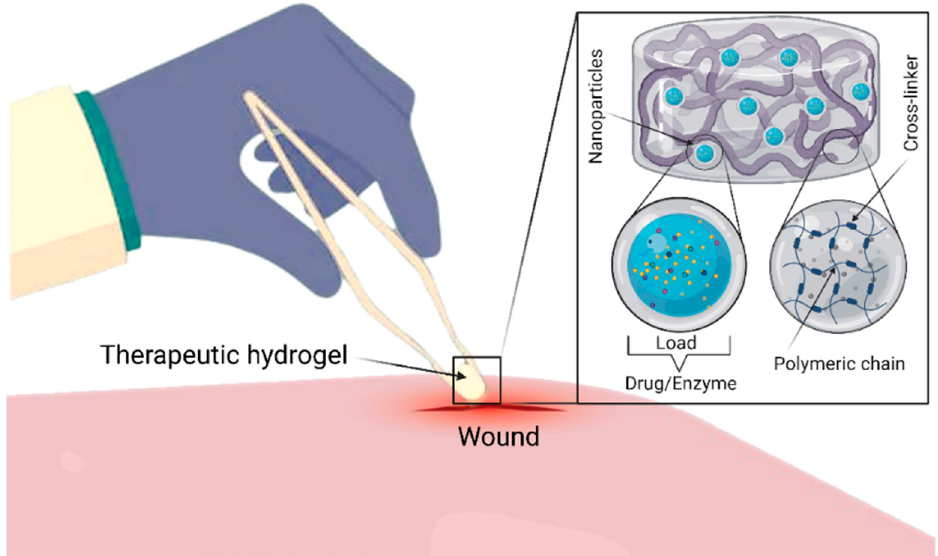
Figure 1. A simplified representation of polymer-based therapeutic gel deployment for wound healing. The Figure was created with “BioRender.com” template and exported under the terms of premium subscription.